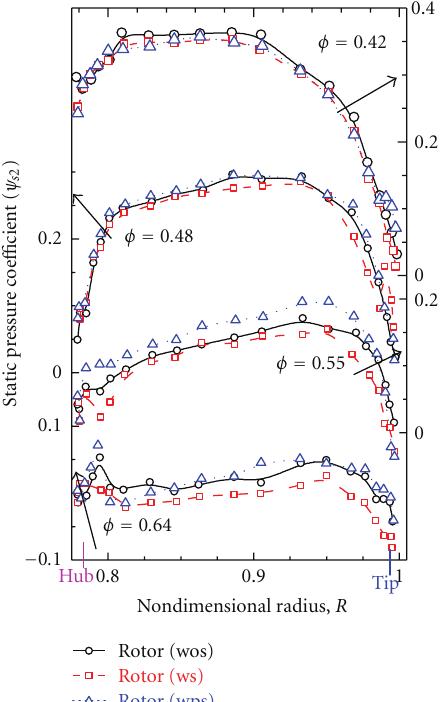
Figure 6: Radial distribution of static pressure coe ffi cient at the rotor exit.